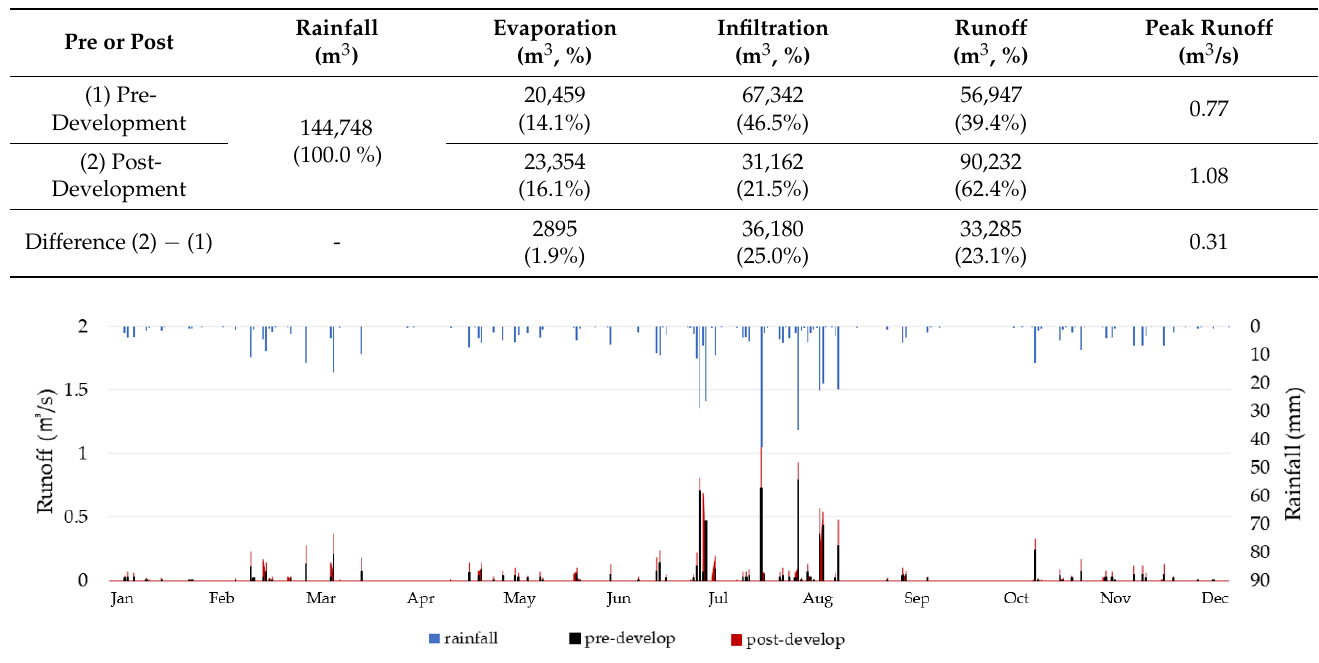
Table 9. Hydrological analysis of the pre- and post-development research site.